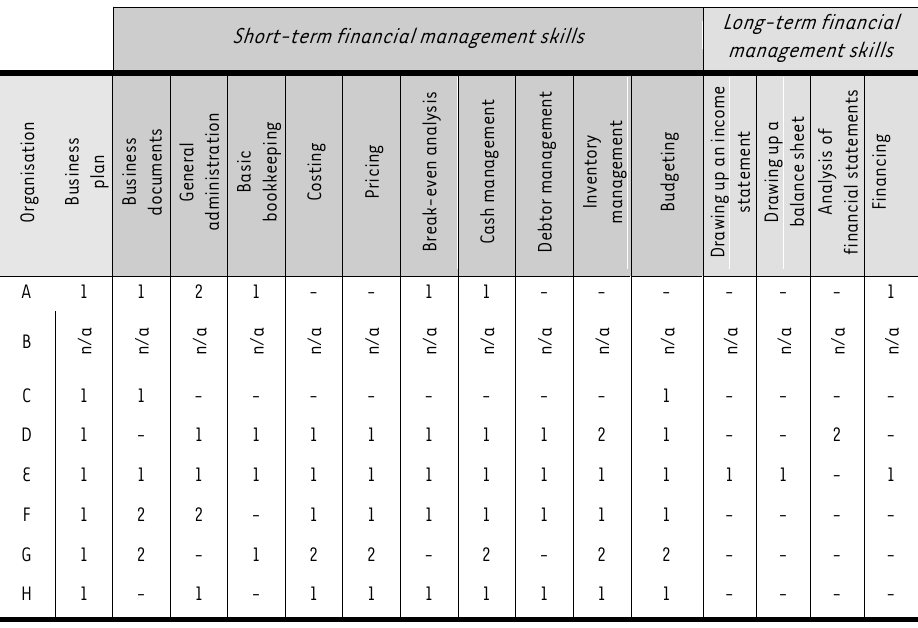
Long-term financial management